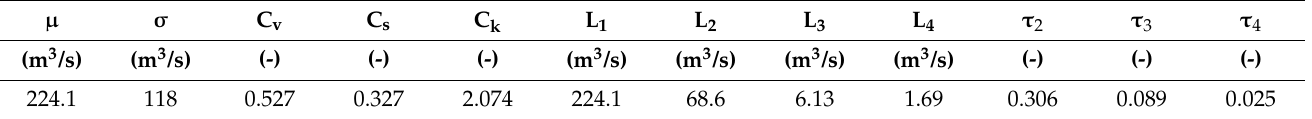
Table 6. The statistical indicators of the observed values.